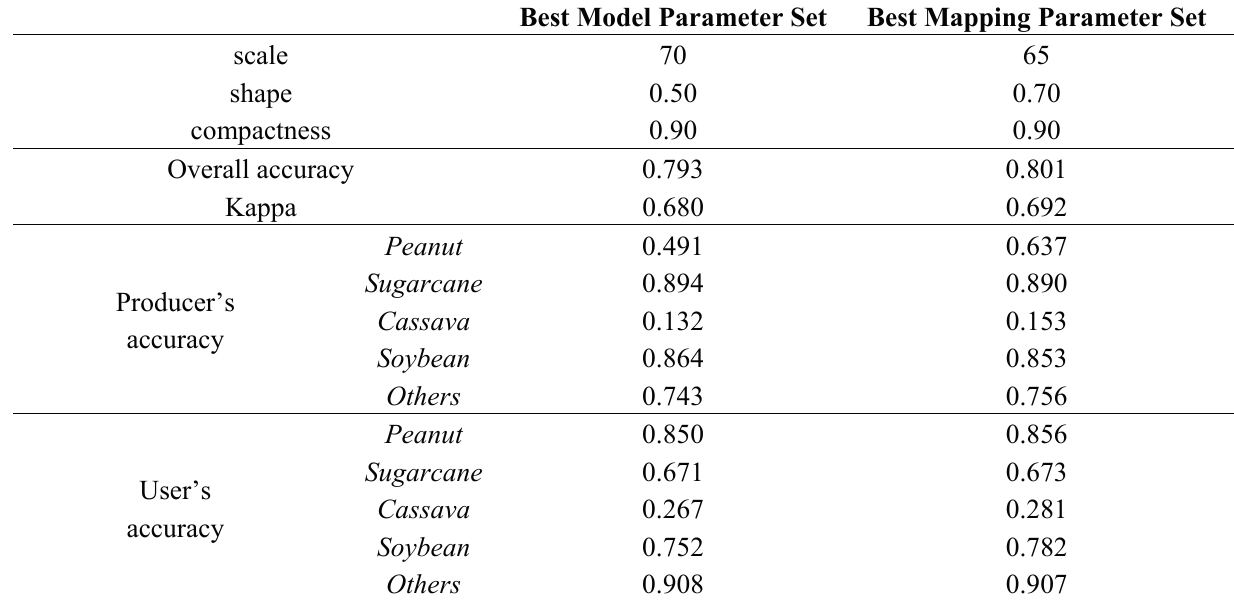
Table 9. Comparison of best parameter sets (and corresponding classification statistics) obtained from reference samples A and B (left) and test sites (C—right). For a fair comparison, the reported classification statistics refer in both cases to the four test sites.